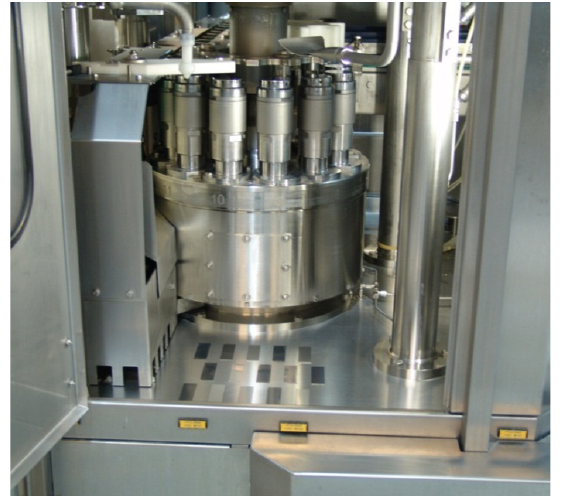
Figure 1. Samples in location at Brewery B.